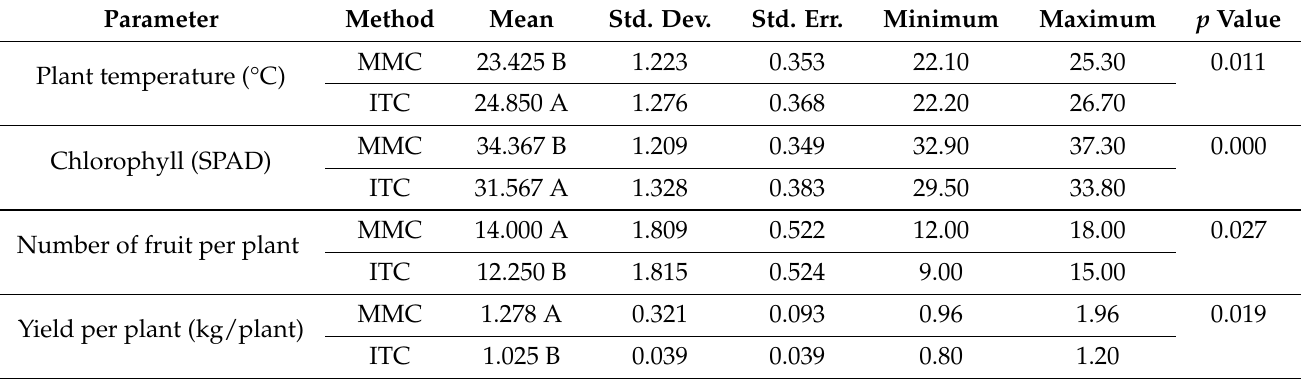
Table 2. Impact of irrigation water control by medium moisture control (MMC) and irrigation timing control (ITC) on cucumber at the same condition of greenhouse microclimate control.